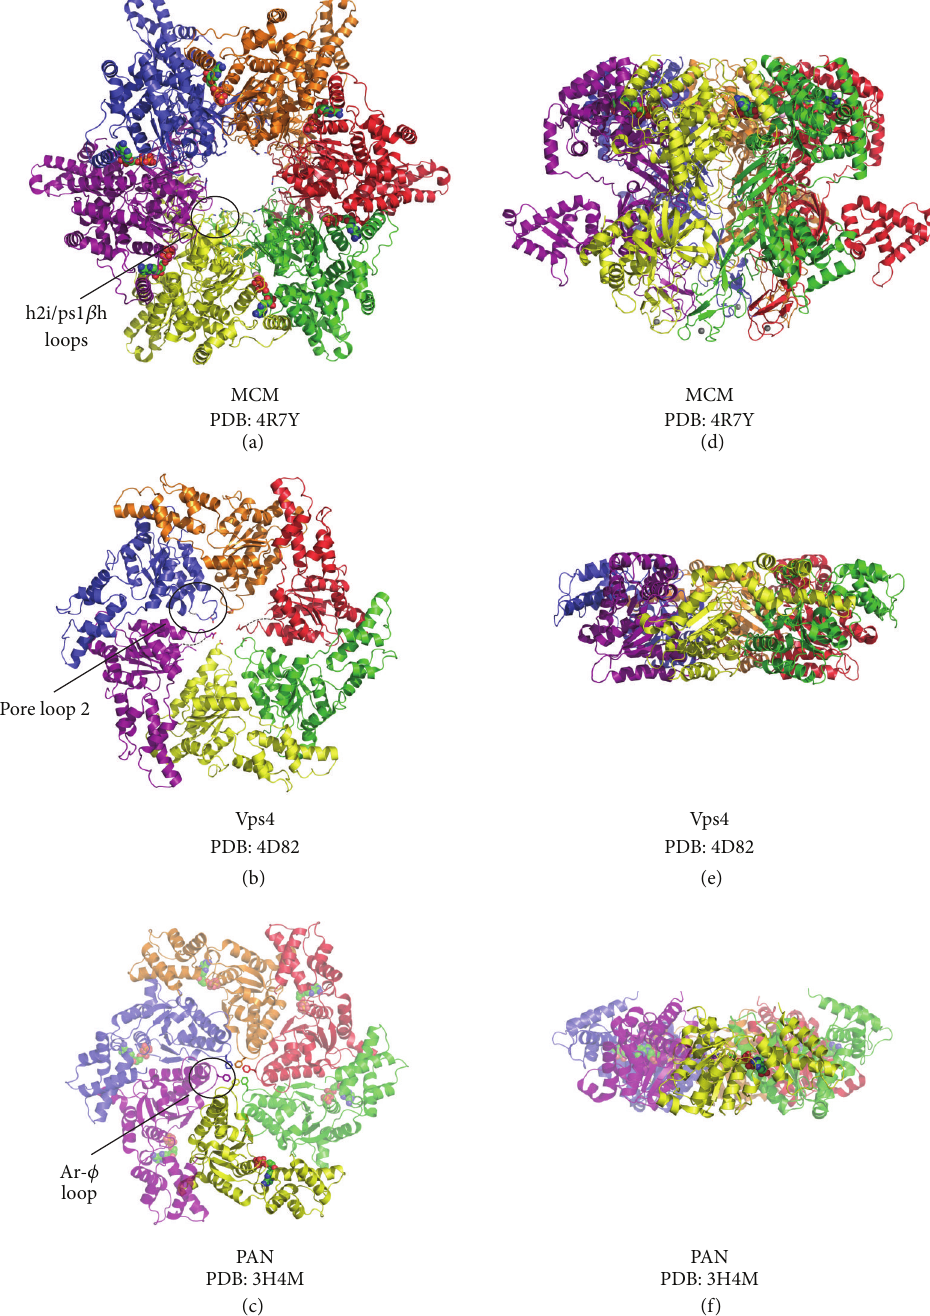
Figure 3: Shared structural features of archaeal AAA+ hexameric translocases. Views of MCM, Vps4, and PAN crystal structures are shown parallel (a–c) and perpendicular (d–f) to the central channel with each subunit uniquely colored and in cartoon representation. In the views parallel to the central channel, the C-terminal face of each complex is projected out of the page. In the perpendicular view, the C-terminus is located at the top and the N-terminus is located on the bottom. (c, f) The PAN hexamer is a model of the nucleotidase ring generated by superimposition of six copies of the PAN monomer atomic coordinates onto the six subunits of of the HslU hexamer (PDB: 1DO0) [49, 50]. Five of the ADP-bound PAN monomers used to generate the model of a hexamer are shown in transparent view (c, f). DNA or protein substrate interaction motifs are projected into the central channel with representative pore loops circled and labelled (a–c). Highlighted pore loop residues are shown in stick, magnesium ions as magenta spheres (a, d), ADP molecules in space-filling view (a, d, c, f), and zinc ions as gray spheres (a, d). All structure representations in the figure were prepared with the Pymol software package [43] and PDB accession codes 4R7Y [41] (a, d), 4D82 [46] (b, e), and 3H4M [50] (c,